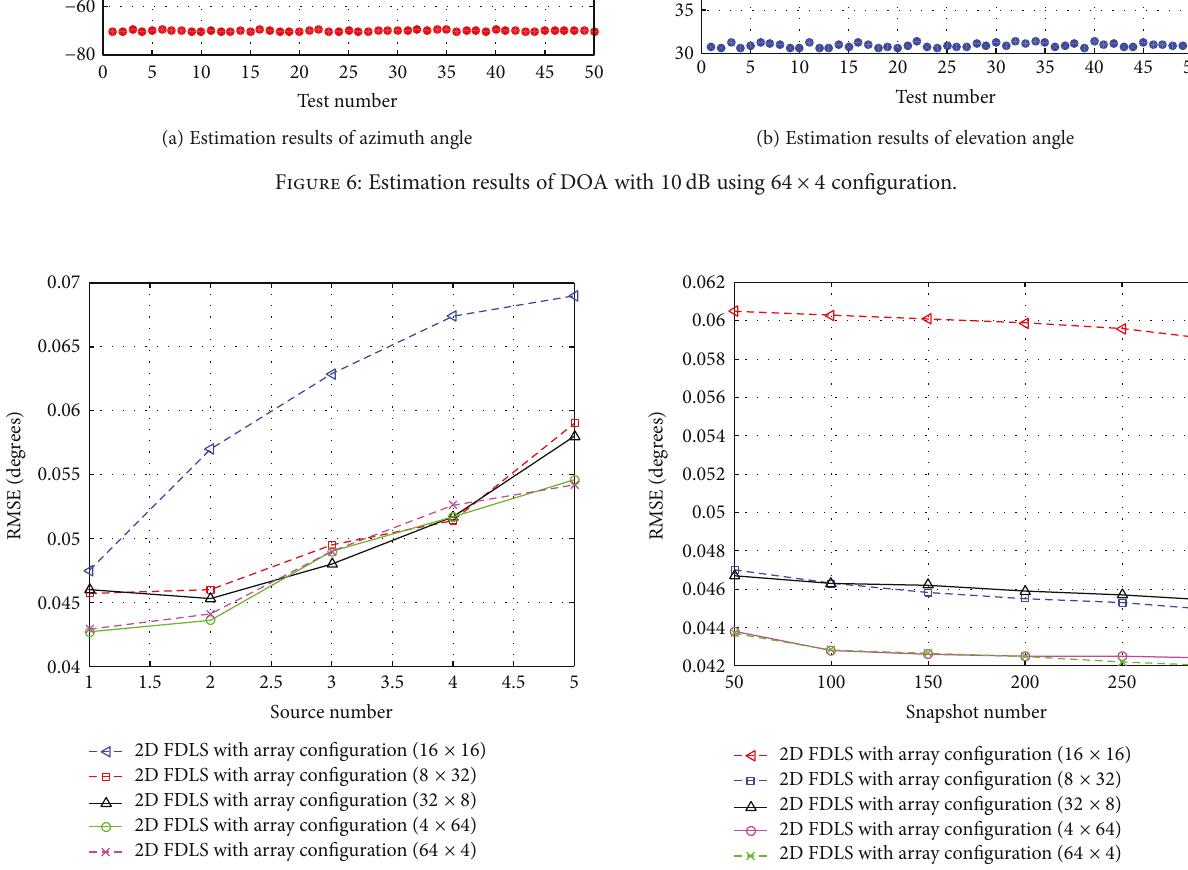
Figure 8: RMSE for massive MIMO DOA estimation versus snapshot number for SNR =10dB with di ff erent types of array con fi